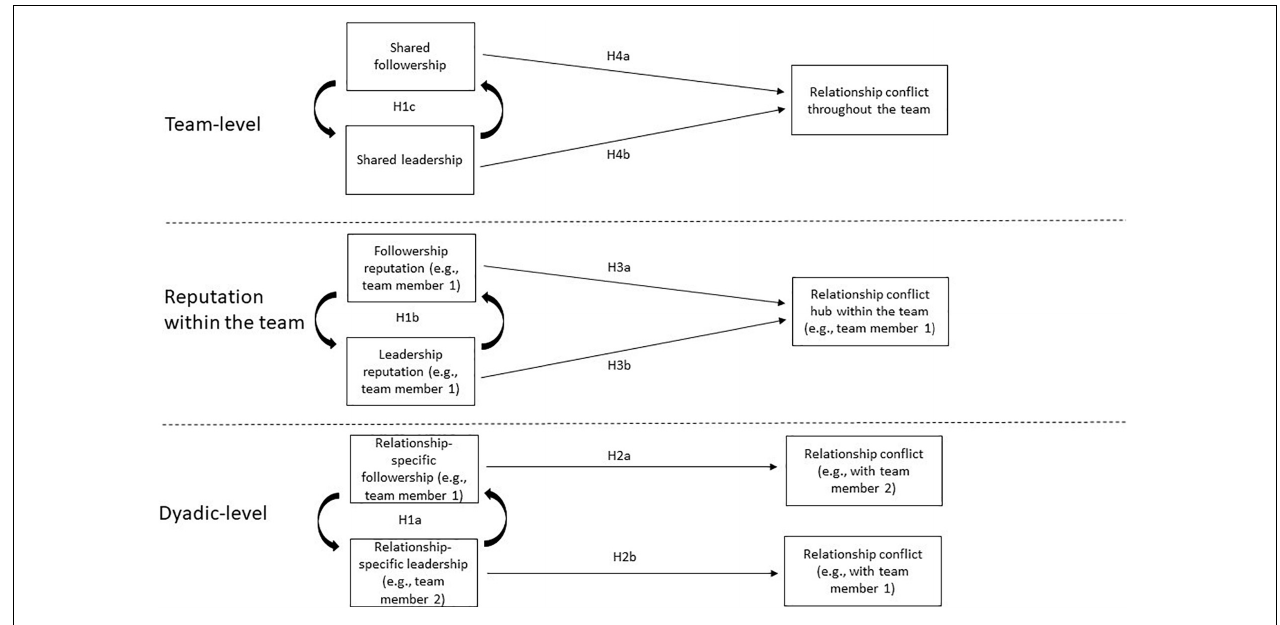
FIGURE 1 | Conceptual model of main